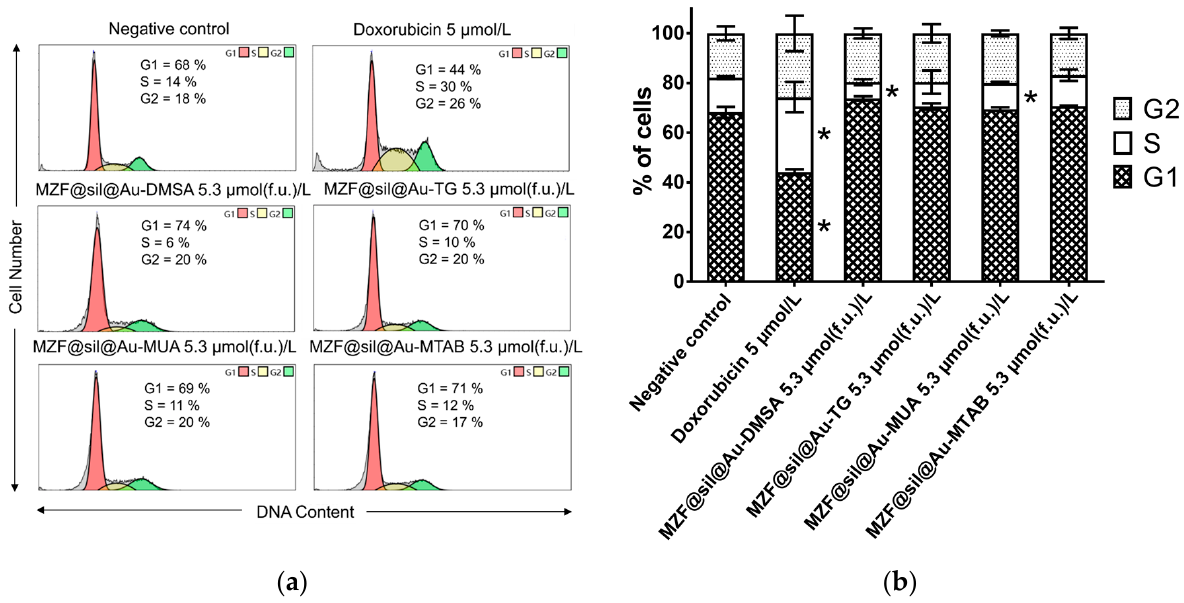
Figure 8. Analysis of the cell cycle of MCF-7 cells 48 h after the application of suspensions of gold nanoshells functionalized with DMSA, TG, MUA, and MTAB with a ferrite concentration of 5.3 µ mol(f.u.) L − 1 : ( a ) Representative histograms with the mean percentage of cells cycling through phases G1, S, and G2 from flow cytometry of three separate treatments; ( b ) the bar graph summarizing the percentage of cells in each phase of the cell cycle. Data are presented as mean values ± SD from three experiments; the asterisk marks the results significantly different ( p ≤ 0.05) from the negative control that was treated with sterile deionized water. Cells treated with 5 µ M doxorubicin were used as a positive